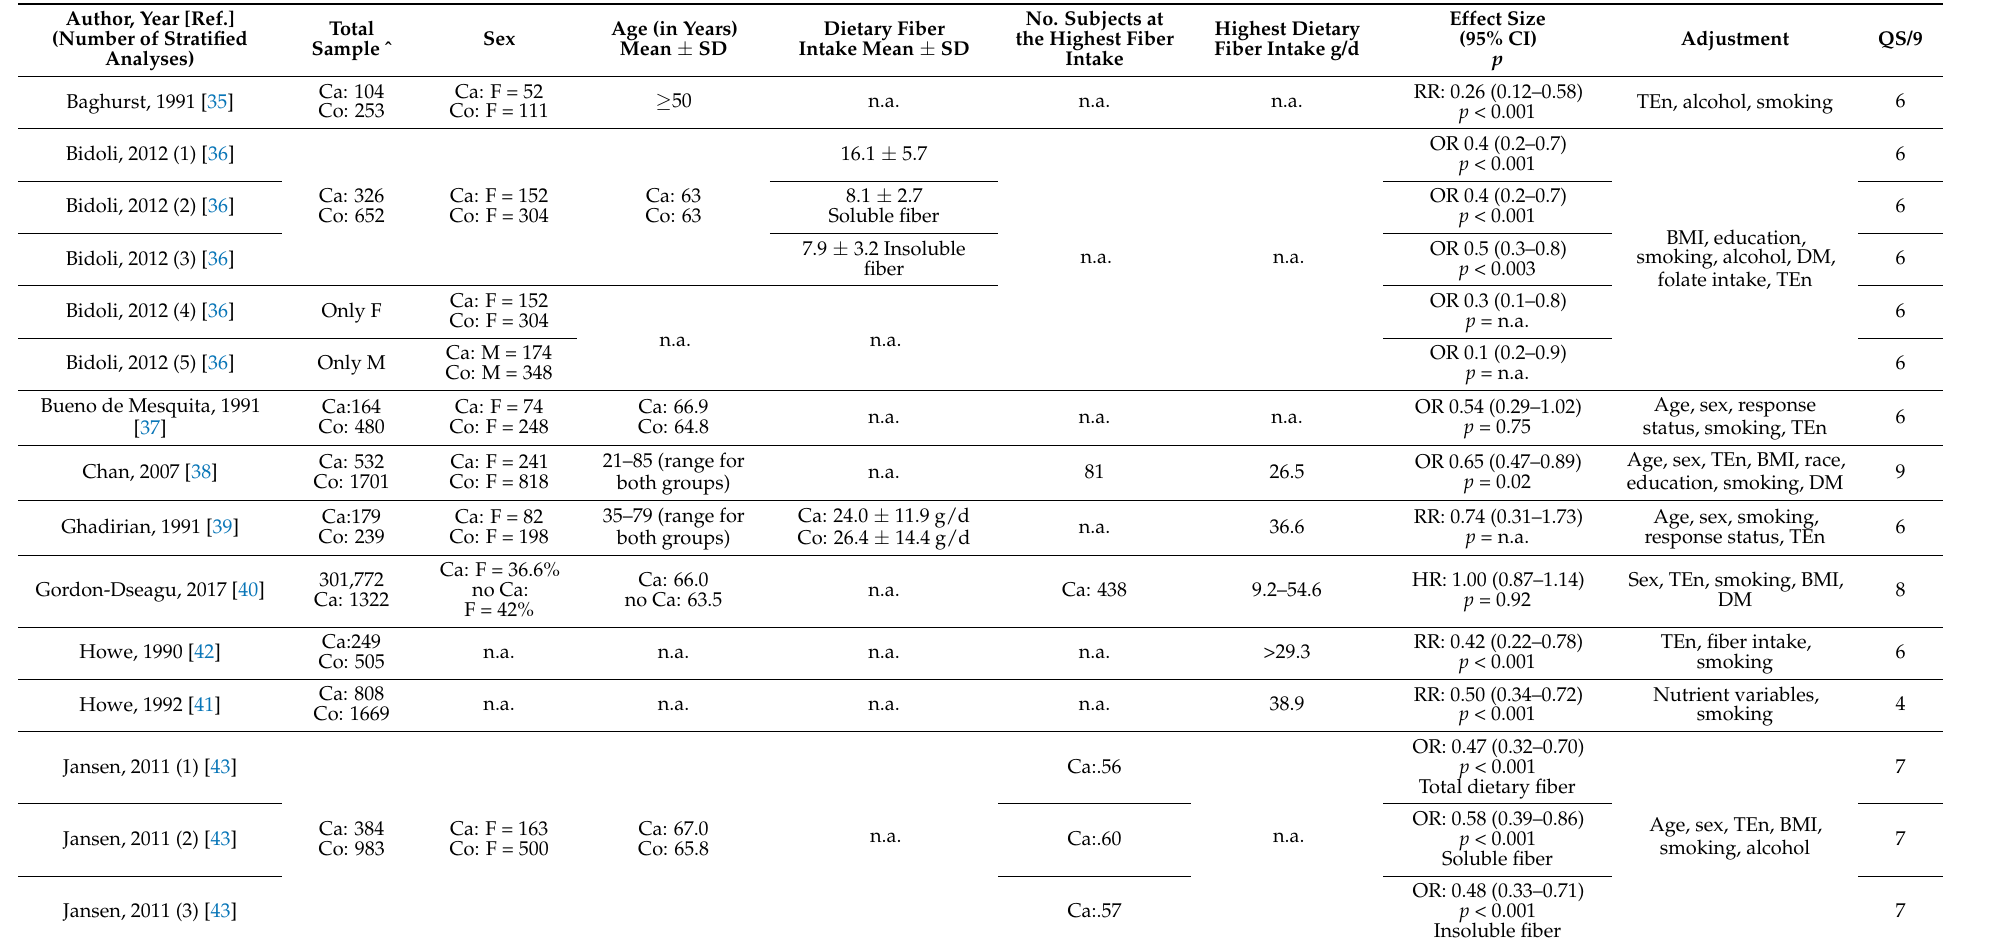
Table 2. Quantitative characteristics of included studies, reported in alphabetical